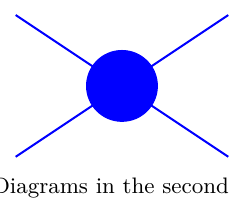
Figure 5. Example of a diagram containing only single trace vertices contributing to the vertex renormalization of f : the solid lines represent propagators of the scalar field Φ , whereas the wavy 1 1 lines represent propagators of the gauge field V . The color indices for the different propagators 12 are indicated in brackets adjacent to the respective propagators. we take the color indices on the two sides to be distinct, i.e., a 6 = b , i 6 = j . Each of the two vertices contributes a factor of g 2 . ∝ λ 1 1 N c 1 Thus, the diagram scales as O ( 1 ) in the large N limit. c 1 N 2 c 1